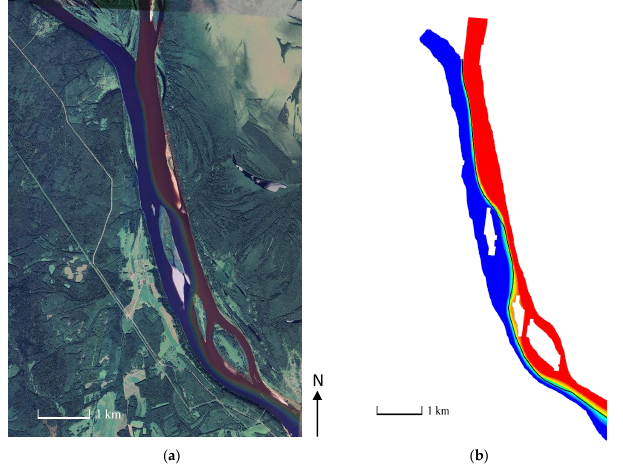
Figure 3. The Google Earth image for the Kama-Vishera junction on the 19 July 2019, showing the classified Kama and Vishera water ( a ). The numerical simulation ( b ) for the same day showing (black line) the digitized mixing interface from 3a superimposed.